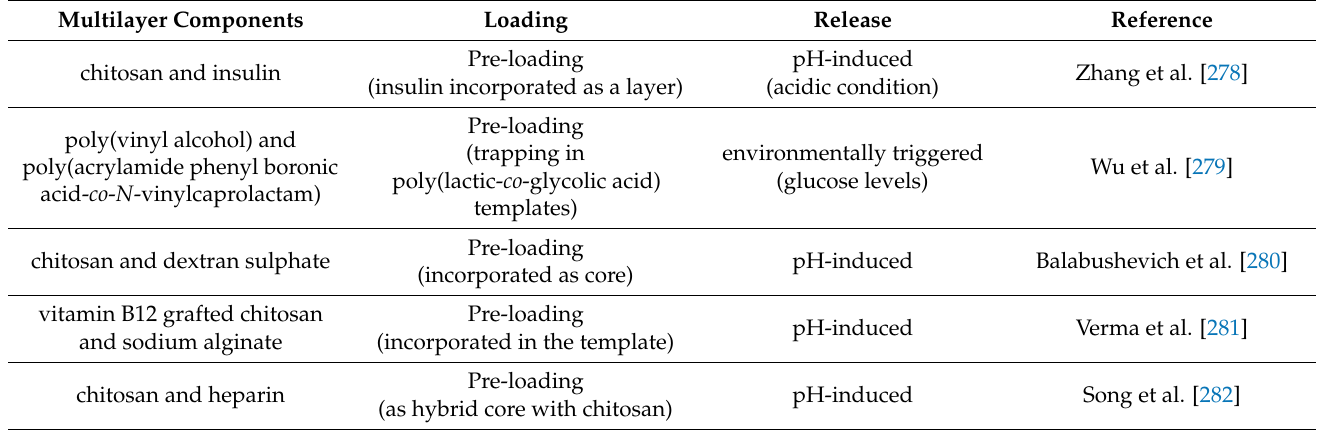
Table 4. Summary of multilayered capsules used for diabetes